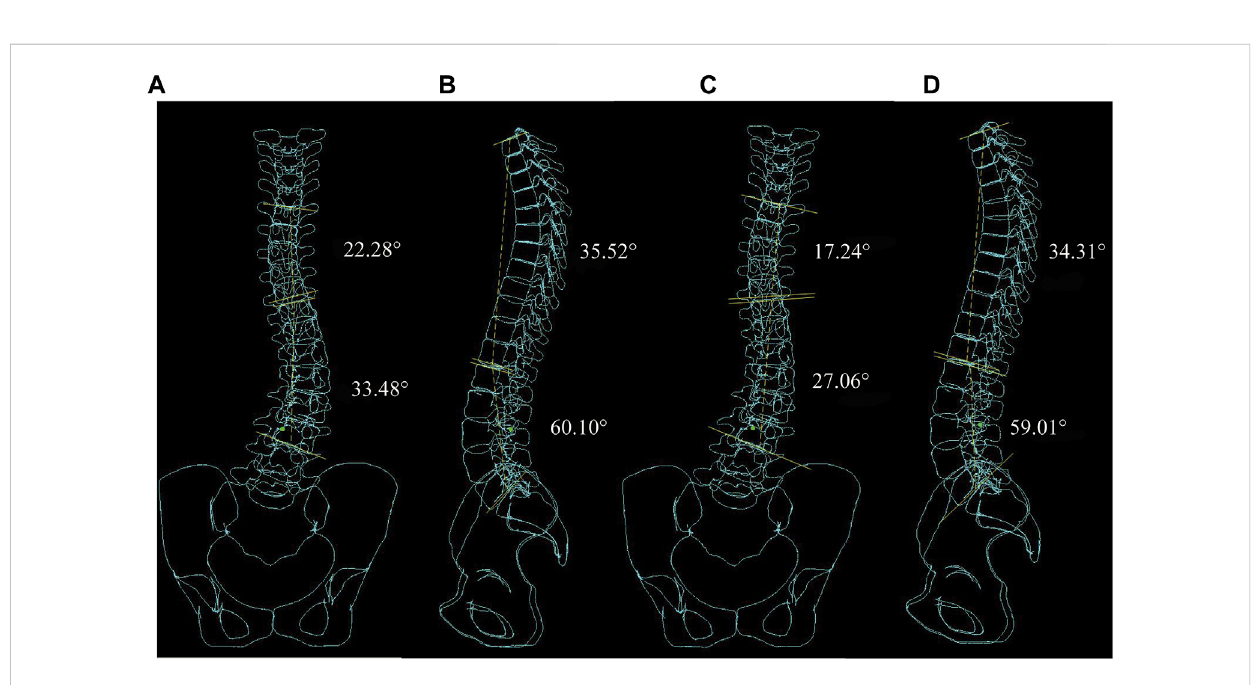
FIGURE 7 Virtual X-ray of normal spinal. (A) Coronal plane Cobb angle measurement in C1. (B) Sagittal plane Kyphosis and Lordosis angle measurement in C1. (C) Coronal plane Cobb angle measurement in C2. (D) Sagittal plane Kyphosis and Lordosis angle measurement in